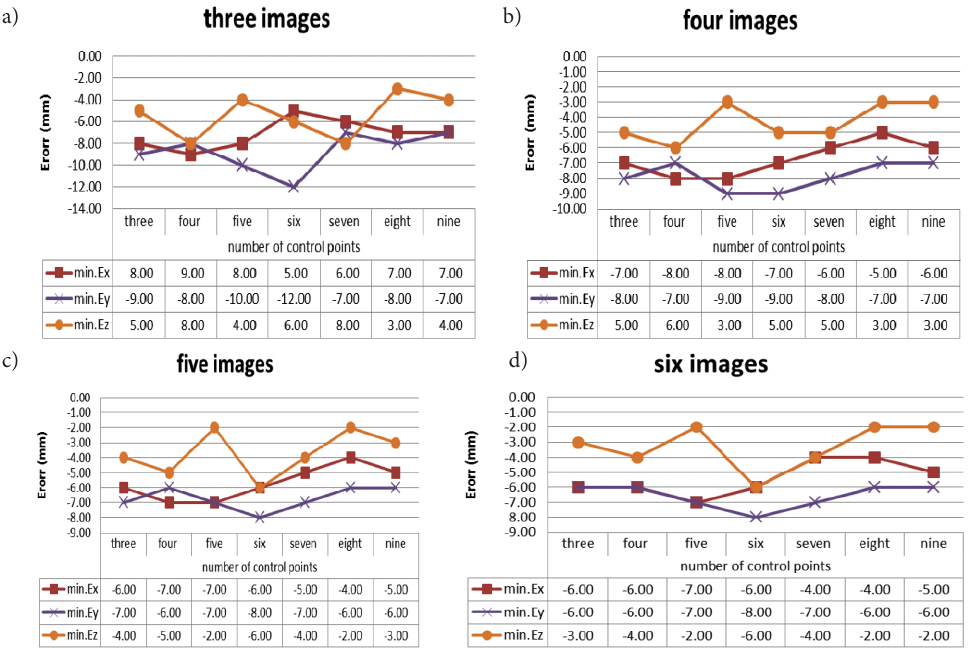
Figure 10. Effect of ground control point’s numbers on minimum point coordinates differences between total station observations and metric camera with photogrammetry